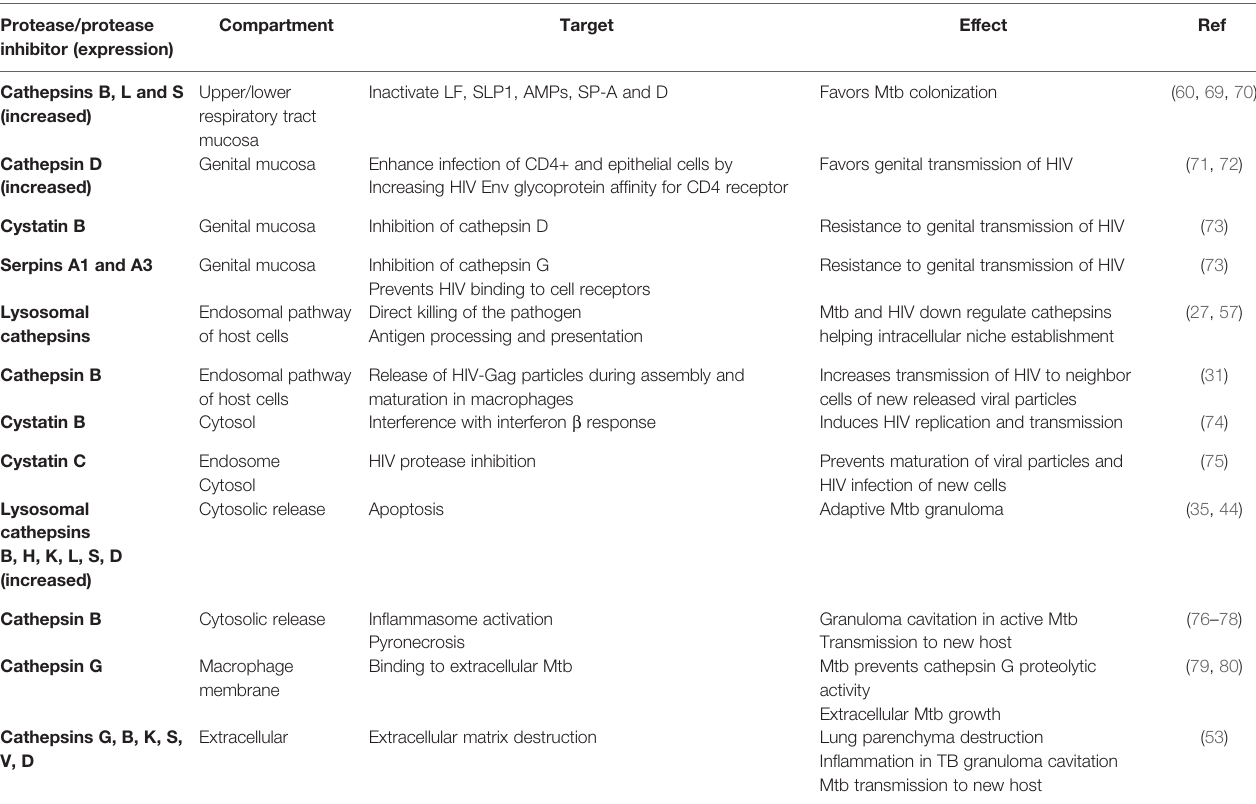
TABLE 1 | Resume on cathepsins and protease inhibitors role in Mtb and HIV infection. Protease/protease inhibitor